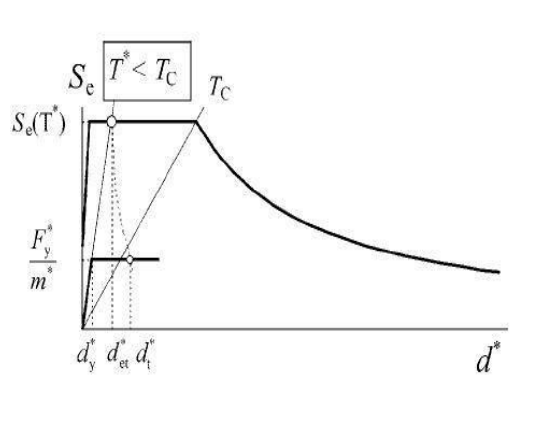
Fig. 12. Short period